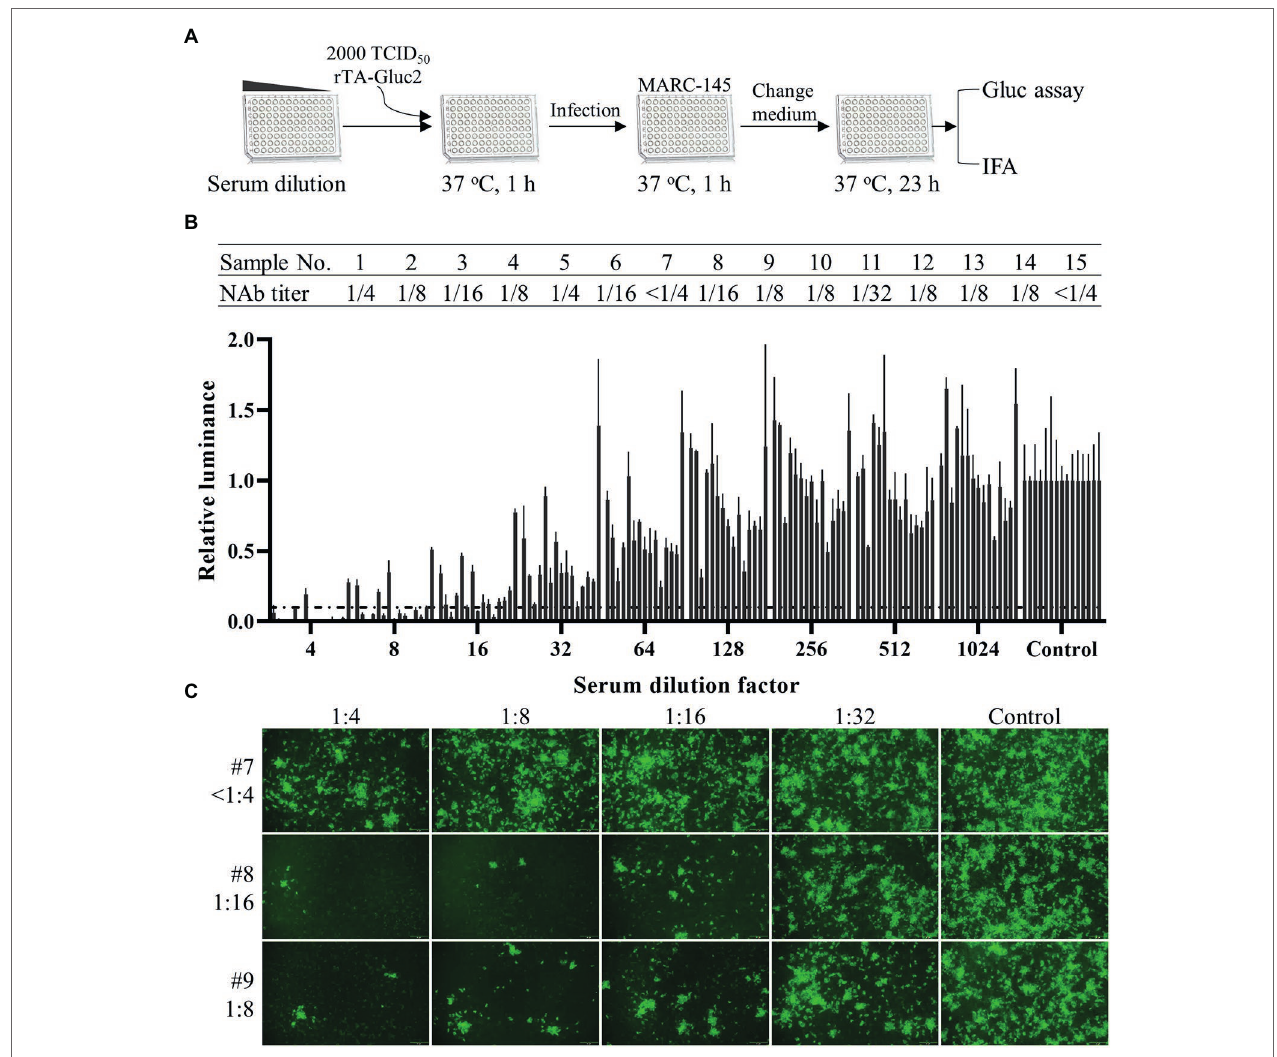
FIGURE 5 | Serum neutralization assay using the Gluc reporter virus. (A) A schematic diagram of the procedure for serum neutralization assay. (B) The titers of neutralizing antibodies in pig serum samples were calculated based on the reduction of gaussia luciferase activity. Each data point represents the mean ± deviation of duplicates. (C) The neutralization of virus infection by selected serum samples was confirmed by IFA detection of N protein